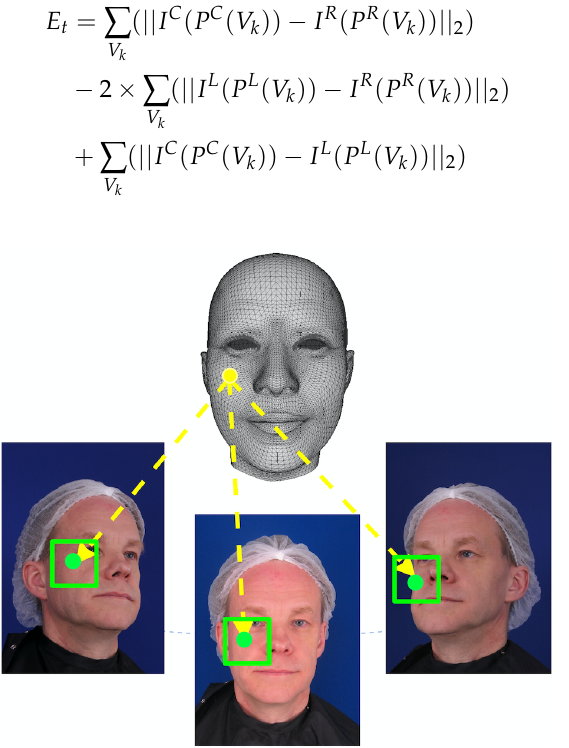
Figure 4. The projection of 3D face mesh vertex (yellow points) and its surrounding neighborhood patch (green